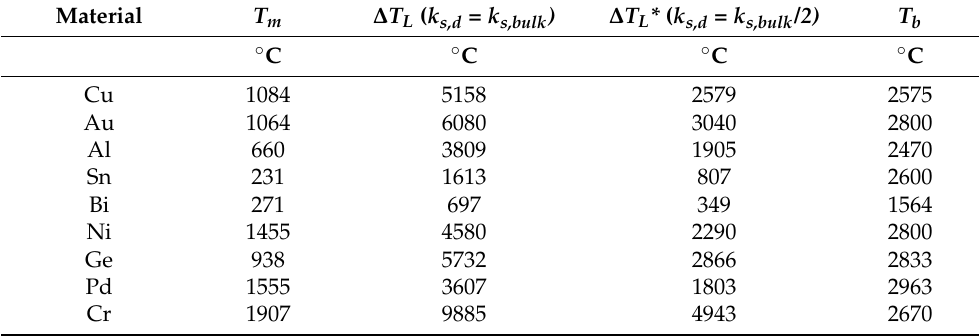
Table 1. ∆ T L calculated for three different cases depending on the factor taken for the droplet thermal conductivity k s,d (Equation (7)). T m and T b are the melting and the boiling temperature, respectively. Material T m ∆ T L ( k s,d = k s,bulk